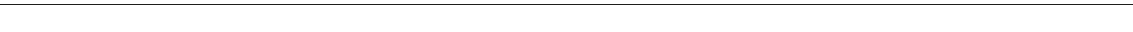
Fig. 1 Projection neuron responses vary in a stimulus-history dependent manner. a , b Distractor-target sequences used in this study are shown. A target stimulus (hexanol — hex or geraniol — ger) was presented solitarily or in a non-overlapping sequence with a distractor cue. All target and distractor stimuli were presented for 4 s. The time interval between the termination of the distractor stimuli and the onset of the target stimulus was 500 ms. c Spiking responses of two different projection neurons (PNs) in the locust antennal lobe are shown. Each tick mark represents an action potential fi red by the PN. Each row corresponds to one trial and PN responses in ten consecutive trials are shown for assessing the repeatability of observed spiking response patterns. The duration when the distractor (blue) and target (red) stimuli were presented are shown using colored boxes. As can be noted, the target stimulus (hex) can be presented solitarily (top panel) or following one of the fi ve different distractor cues: history1 — 2octanol (2oct), history2 — isoamyl acetate (iaa), history3 — benzaldehyde (bzald), history4 — citral (cit), and history5 — apple (app). d Similar plots as in c but showing responses of two more PNs to presentations of geraniol (ger) with different stimulus histories. e Responses of 85 PNs projected onto the fi rst three principal components are shown. Each spoke represents the ensemble neural activities in a 50 ms time bin after PCA dimensionality reduction. Arrows indicate direction of evolution of the stimulus-evoked responses over time. The six trajectories shown correspond to PN responses observed following the introductions of the target stimulus either solitarily or in one of fi ve stimulus sequences. f Similar trajectory plots as in e but visualizing ensemble PN responses evoked by introductions of geraniol (ger) with different stimulus histories. g Population PN responses are shown after linear discriminant analysis dimensionality reduction ( n = 85 PNs). Each 3D-sphere represents an 85-dimensional PN activity vector in a 50 ms time bin. Eighty data points corresponding to ensemble neural activities evoked during 4 s of hexanol exposure with a particular stimulus history are assigned the same color. h Similar plot as in g but showing responses elicited during geraniol